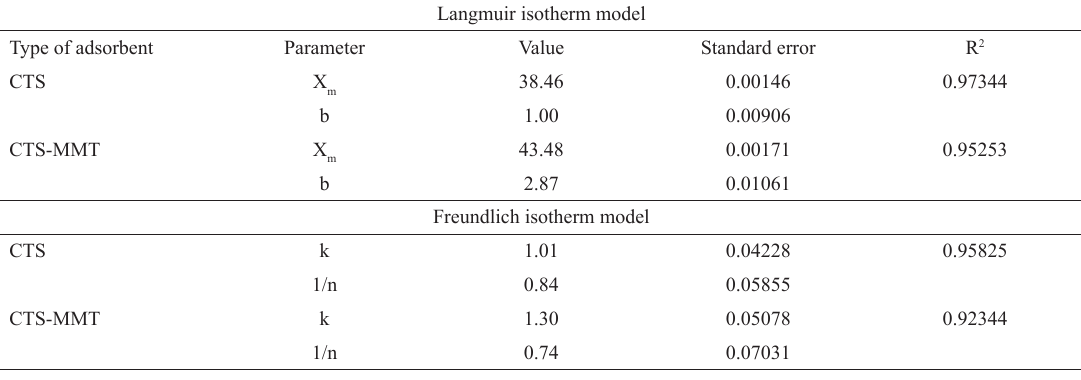
Table 1: Parameter of the Langmuir and Freundlich isotherm models for CTS and CTS-3%MMT composite beads.